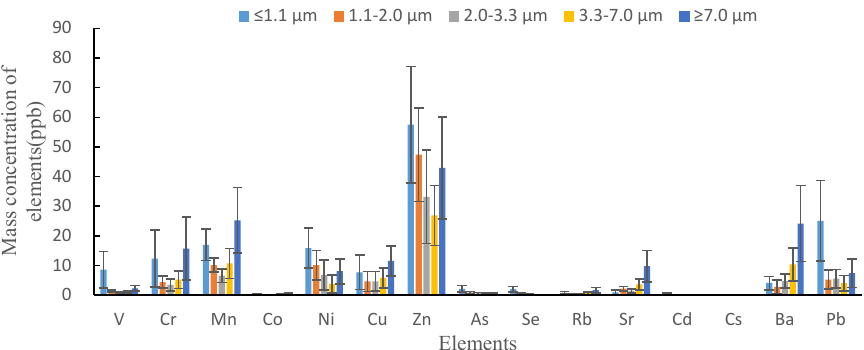
Figure 4. Mass concentration of anthropogenic elements in the size-resolved particles.